Question: Describe this figure in one sentence.
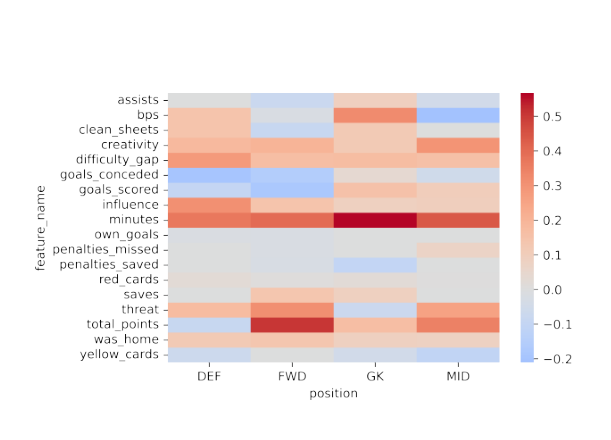
Answer: For LightGBM, we can examine in Figure 4 what percentage of all the splits is based on a given feature as a proxy for its importance. Alternatively, visualized in Figure 7, Shapley values can illustrate each feature’s numerical contribution to the final tree ensemble output, adding some much needed explainability (Lundberg et al., 2020). First, we observe several features that are consistently important for both baseline models. Those include, for example, minutes (as players with more playtime have more opportunities to score points and are more likely recognized by the team to be on the starting lineup), difficulty gap (as the opponent’s relative strength to the player’s team can translate to ball possession percentages and pressure), influence/creativity/threat (as these FPL-compiled metrics take into account finer-grained match-events beyond low occurrence events such as goals and assists), and total points (as this sliding-window average of recent weeks’ points is a fair